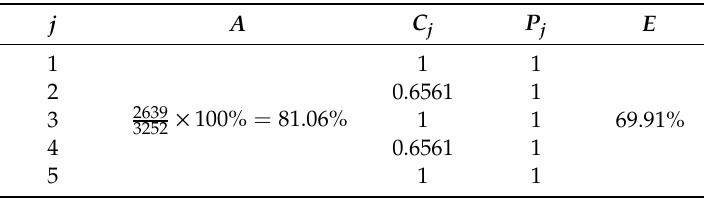
Table 7. E ff ectiveness